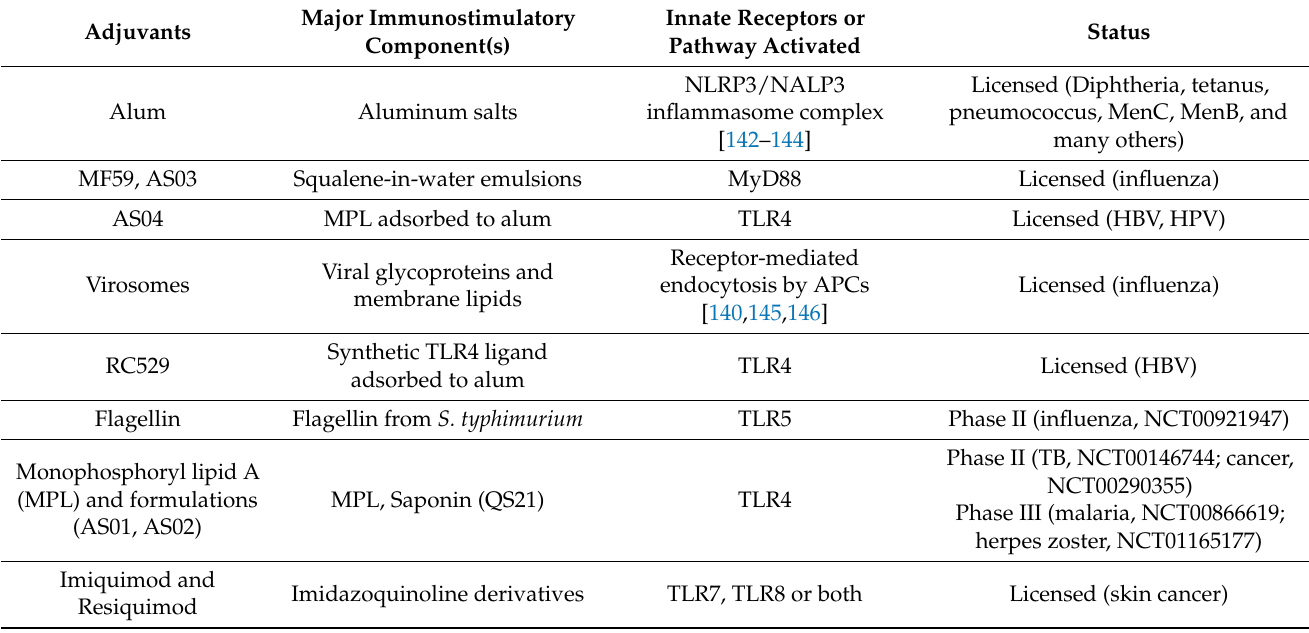
Table 2. Clinically tested human vaccine adjuvants. Adapted with permission from [135,140,141]. Copyright 2017,